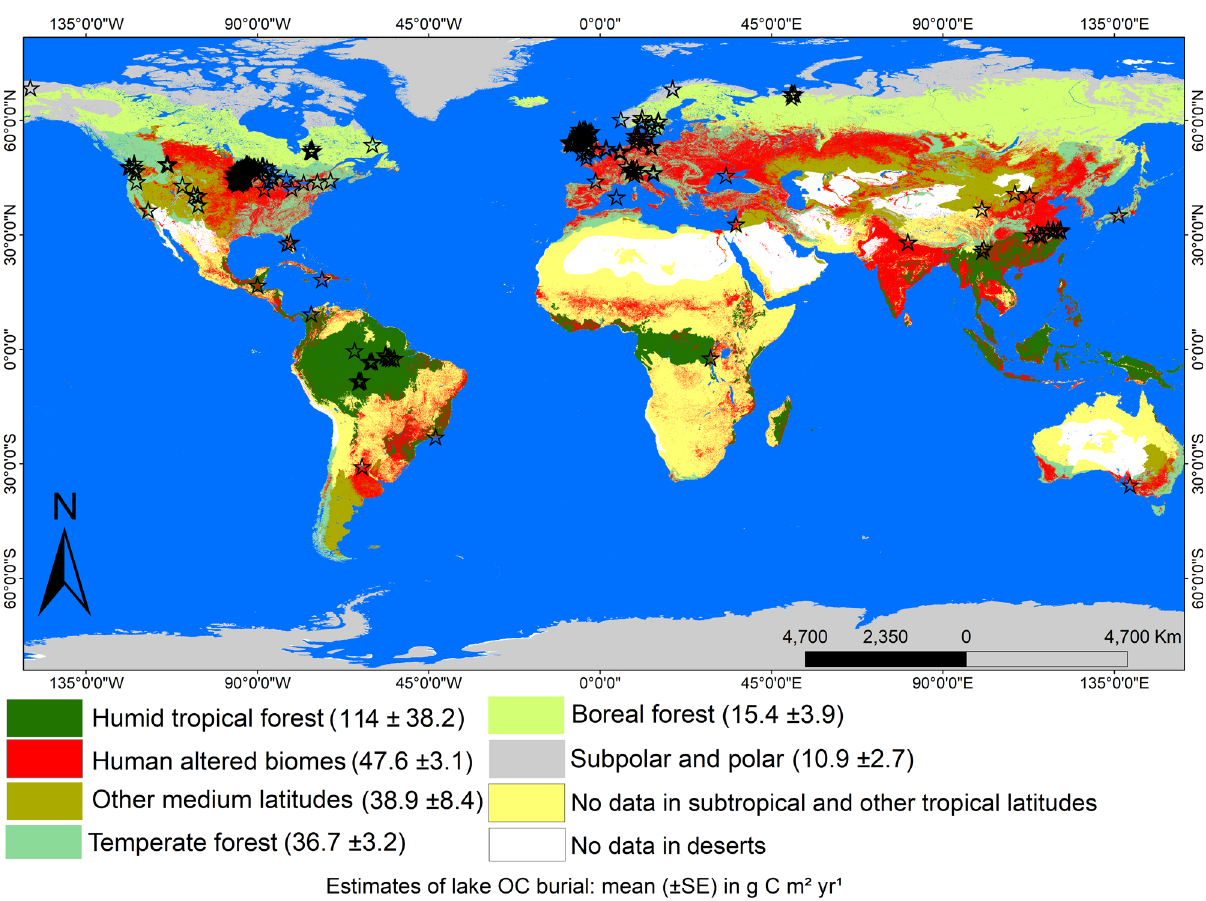
Fig. 1 Global distribution of OC burial rates (average ± SE) in lakes across biomes. The red color indicates human-altered areas, while black stars the locations of the study lakes. No data were available for subtropical, other tropical latitudes, and